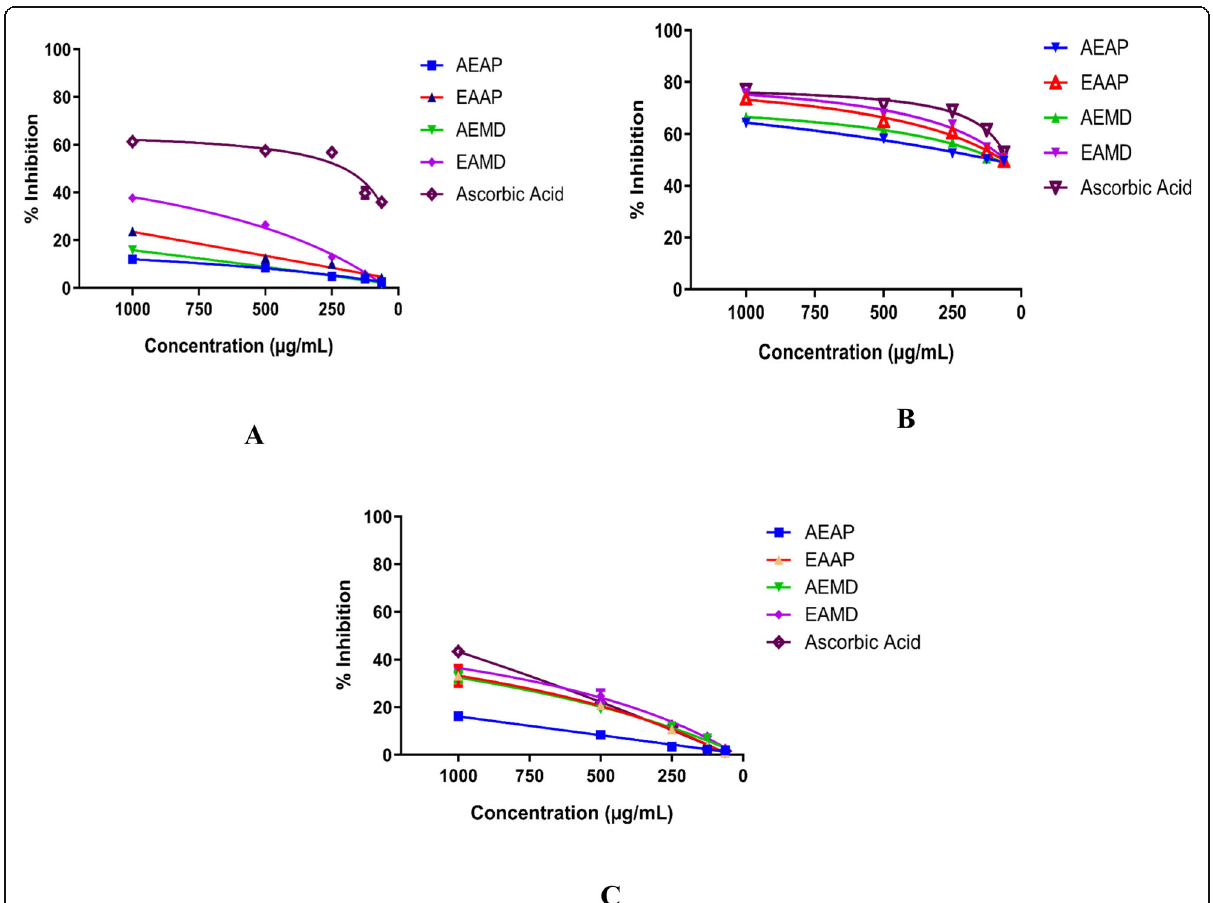
Fig. 1 Free radical scavenging activity of extracts: a Scavenging activity by DPPH assay. b Hydroxyl radical scavenging activity. c Superoxide radical scavenging activity. The values are presented as mean ± SD, ( n = 3)